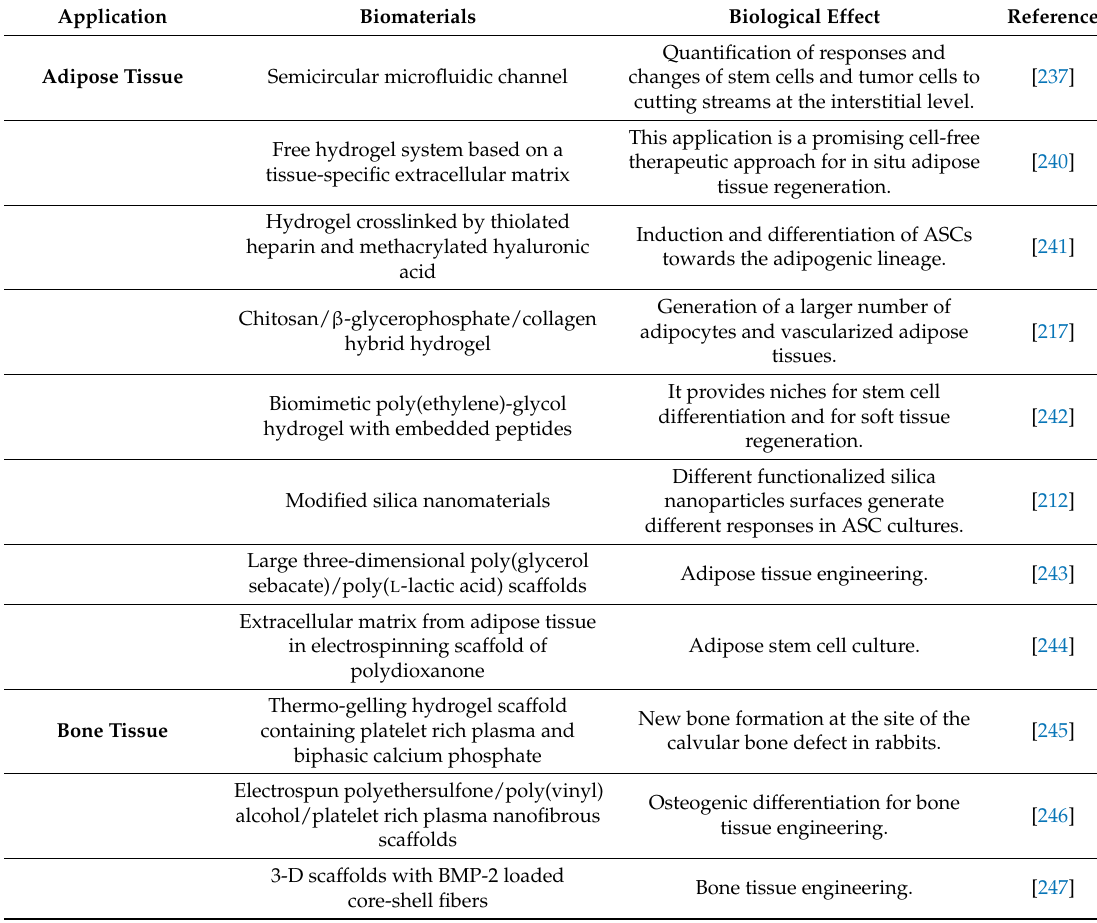
Table 4. Adipose stem cells and tissue engineering applications. The table reports the most recent applications of tissue engineering with ASCs and biomaterials of different